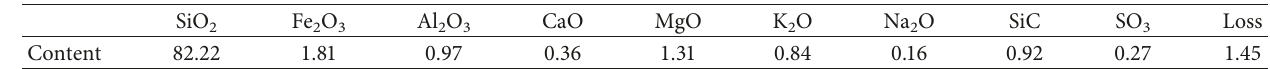
Table 2: The examination result of silica fume (wt.%).